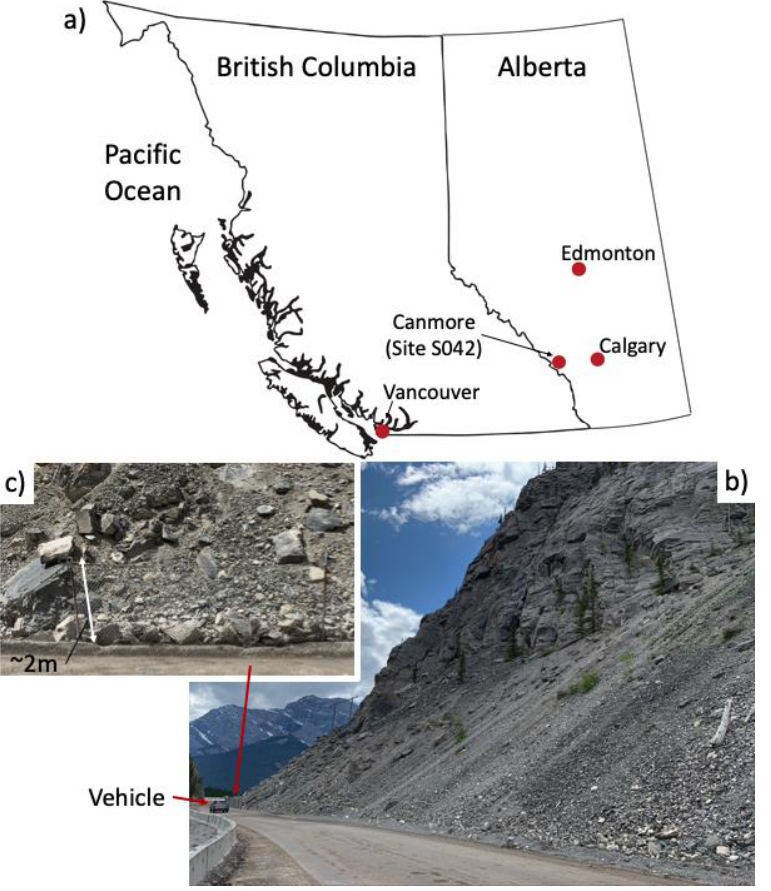
Figure 3. Location of Site S042 ( a ), view of the rock face towards the southwest direction ( b ), and detail of blocks contained behind a 2m height fence at the toe of the talus slope ( c ).